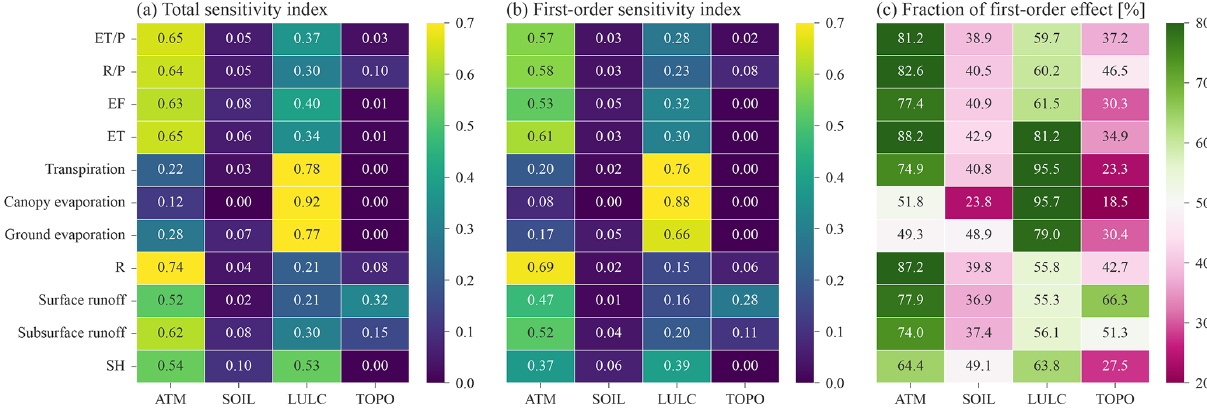
Figure 4. CONUS-averaged (a) Sobol’ total sensitivity index, (b) Sobol’ first-order sensitivity index, and (c) the fraction of first-order effect for the sensitivity of spatial variability of different variables (rows) to the four heterogeneity sources